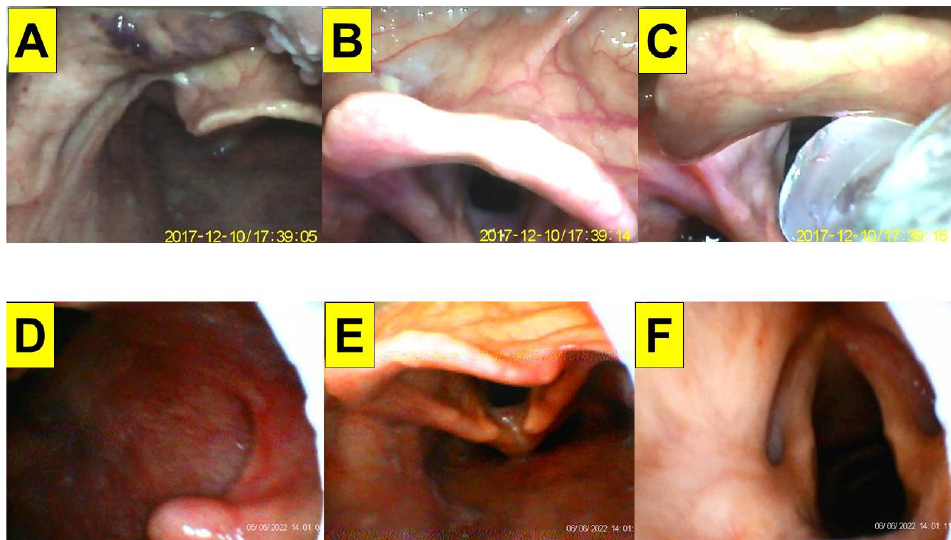
Figure 7. Application of video-twins technique in a patient (a 71-year-old man with a BMI 18.3 kg/m 2 ) contracted COVID-19 underwent tongue biopsy and genitourinary surgeries. Mallampati class was not evaluated and Cormack-Lehane laryngoscopic view was grade 2a: ( A – C ) video- laryngoscopic views; and ( D – F ) views from intubating stylet. The proper position of the IONM tube over the vocal cords was confirmed ( C ). Intubation time was 6 s. (also see the Supplementary Materials — Videos S10 and S11). Intubating devices: UE and Trachway.